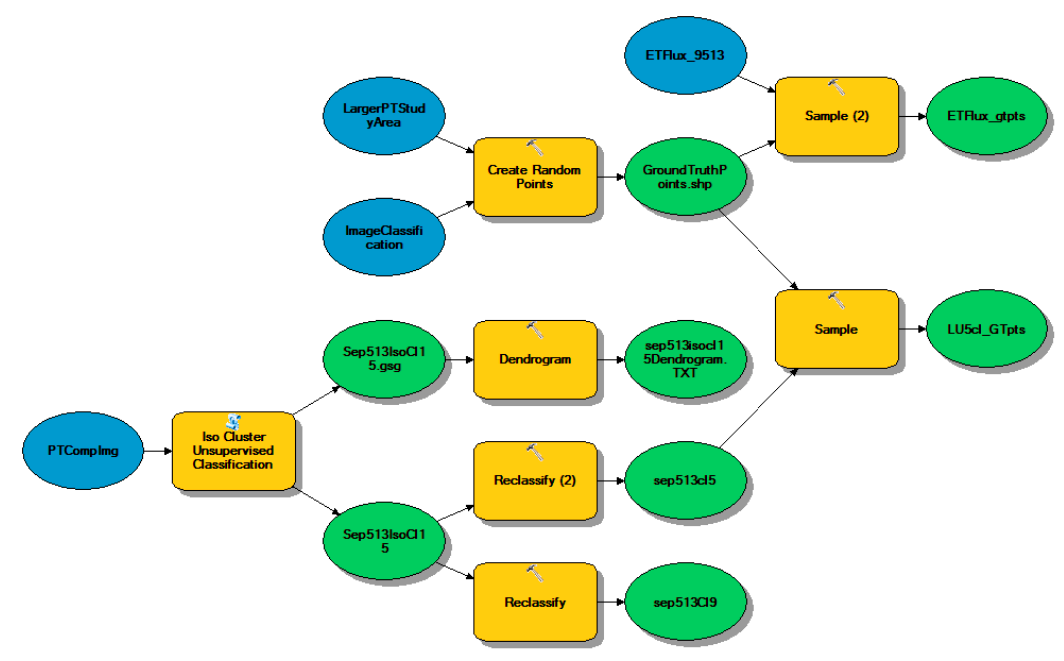
Figure 4. Automated geospatial model developed in ArcGIS ModelBuilder to conduct ET flux estimation validation with study area Landuse with ground-truth samples.